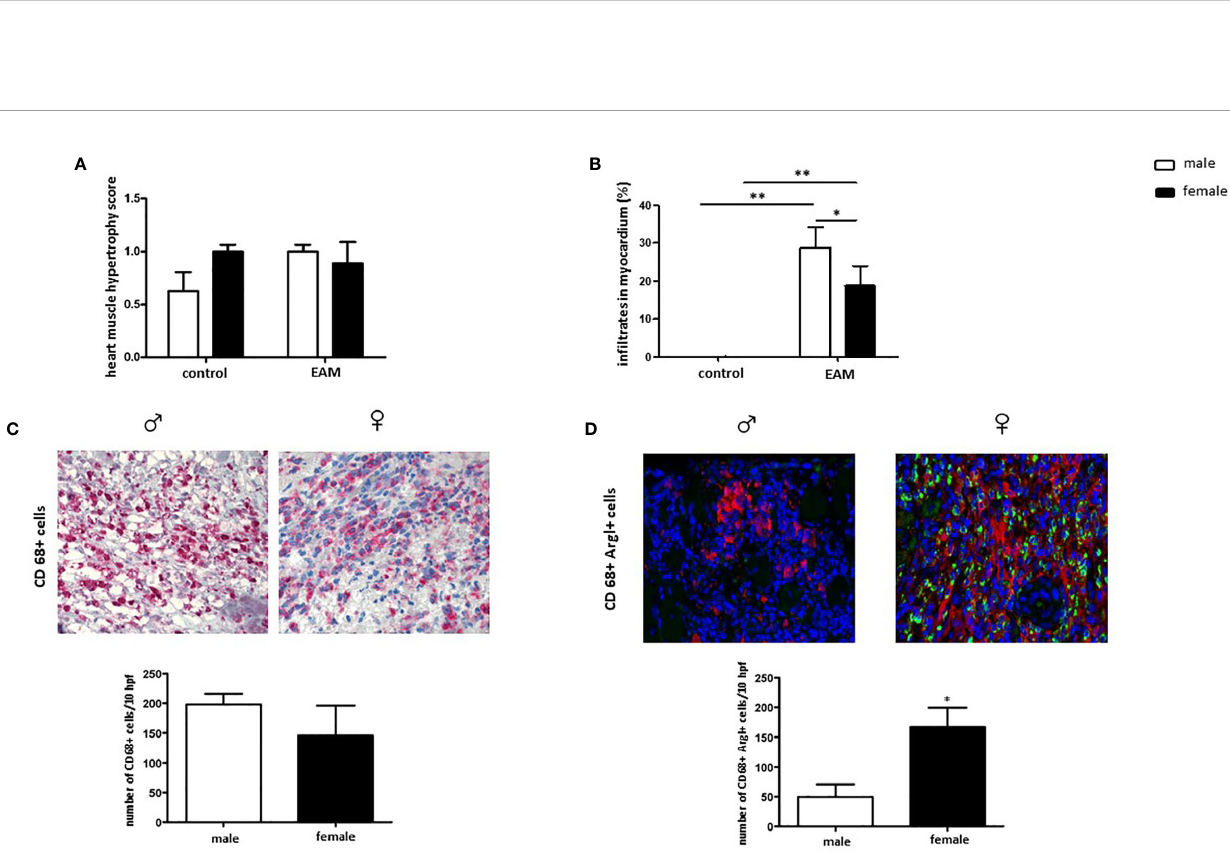
FIGURE 2 | Increased number of cardiac CD68+ ArgI+ macrophages in female EAM rats. Immunohistochemical analysis of heart muscle hypertrophy (A) , myocardial immune in fi ltrates (B) , CD68+ immune-reactive cells (C) , and CD68+ ArgI+ cells (D) in myocardial tissue in male and female EAM animals. Data are shown as mean ± SEM (n= 4-12). *p < 0.05, **p < 0.01. Representative images of cardiac cryosections stained with antibodies against CD68 (C) and CD68 and ArgI (D) in myocardial tissue in male ( ♂ ) and female ( ♀ ) EAM animals (n= 4-12). Magni fi cation